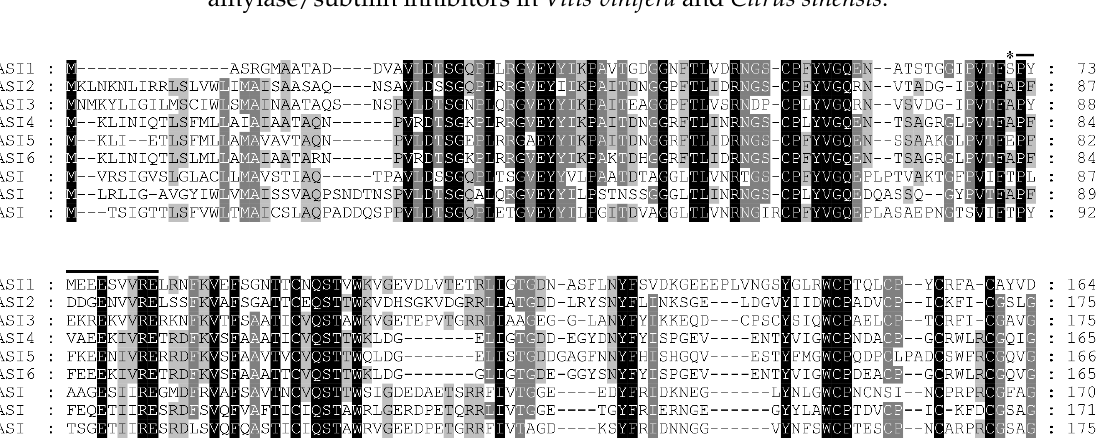
Figure 1. Multiple sequence alignment of MnASIs with other α -amylase/subtilisin inhibitors. A solid line indicates the reactive loop. An asterisk shows the catalytic residue against subtilisin. A pound sign shows the catalytic residue against α -amylase. The accession numbers obtained from GenBank are as follows: RcASI ( Ricinus communis , XP_002525871), VvASI ( Vitis vinifera , XP_002265535), and PtASI ( Populus trichocarpa , XP_006383817). The protein sequences of other plant α -amylase/subtilisin inhibitors obtained from NCBI were multiple aligned. Phylogenetic and molecular evolutionary analyses were per- formed using MEGA 6 to explore the evolutionary relationships among different species (Figure 2). The results showed that the MnASIs proteins of mulberry clustered together and were more distantly related to the α -amylase/subtilin inhibitors in Aegilops tauschii , Hordeum vulgare , and Brachypodium distachyon , and were more closely related to the α - amylase/subtilin inhibitors in Vitis vinifera and Citrus sinensis .